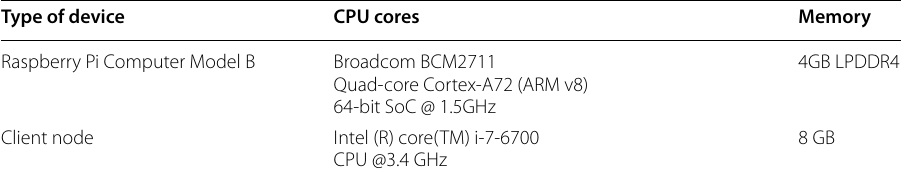
Table 1 Raspberry hardware